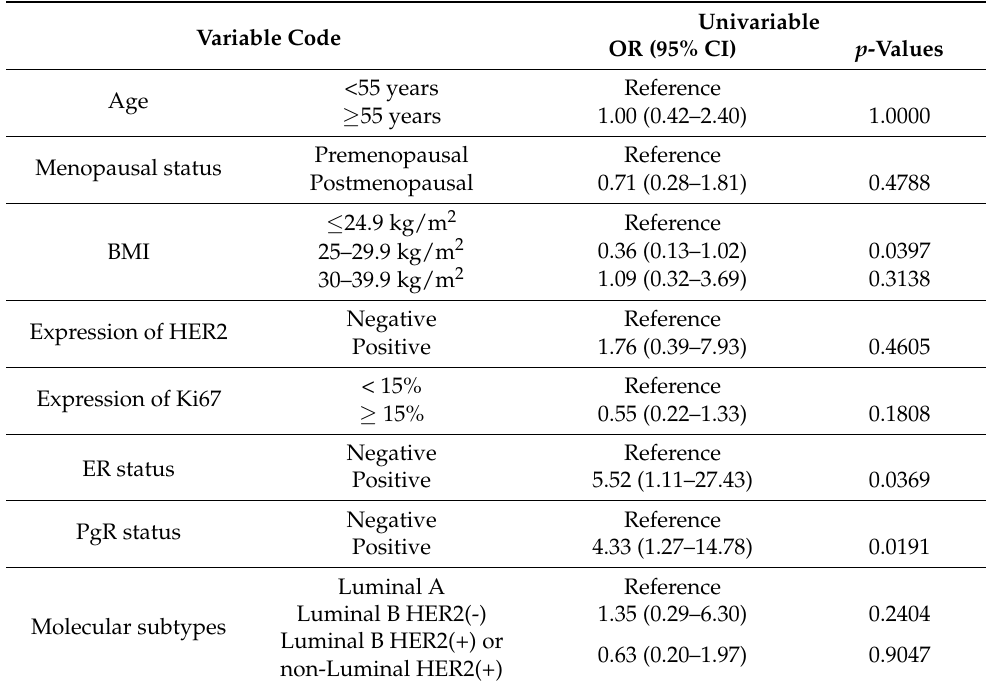
Table 5. Univariate logistic regression analyses of low or high pre-treatment heparanase concentration predictors in IBrC